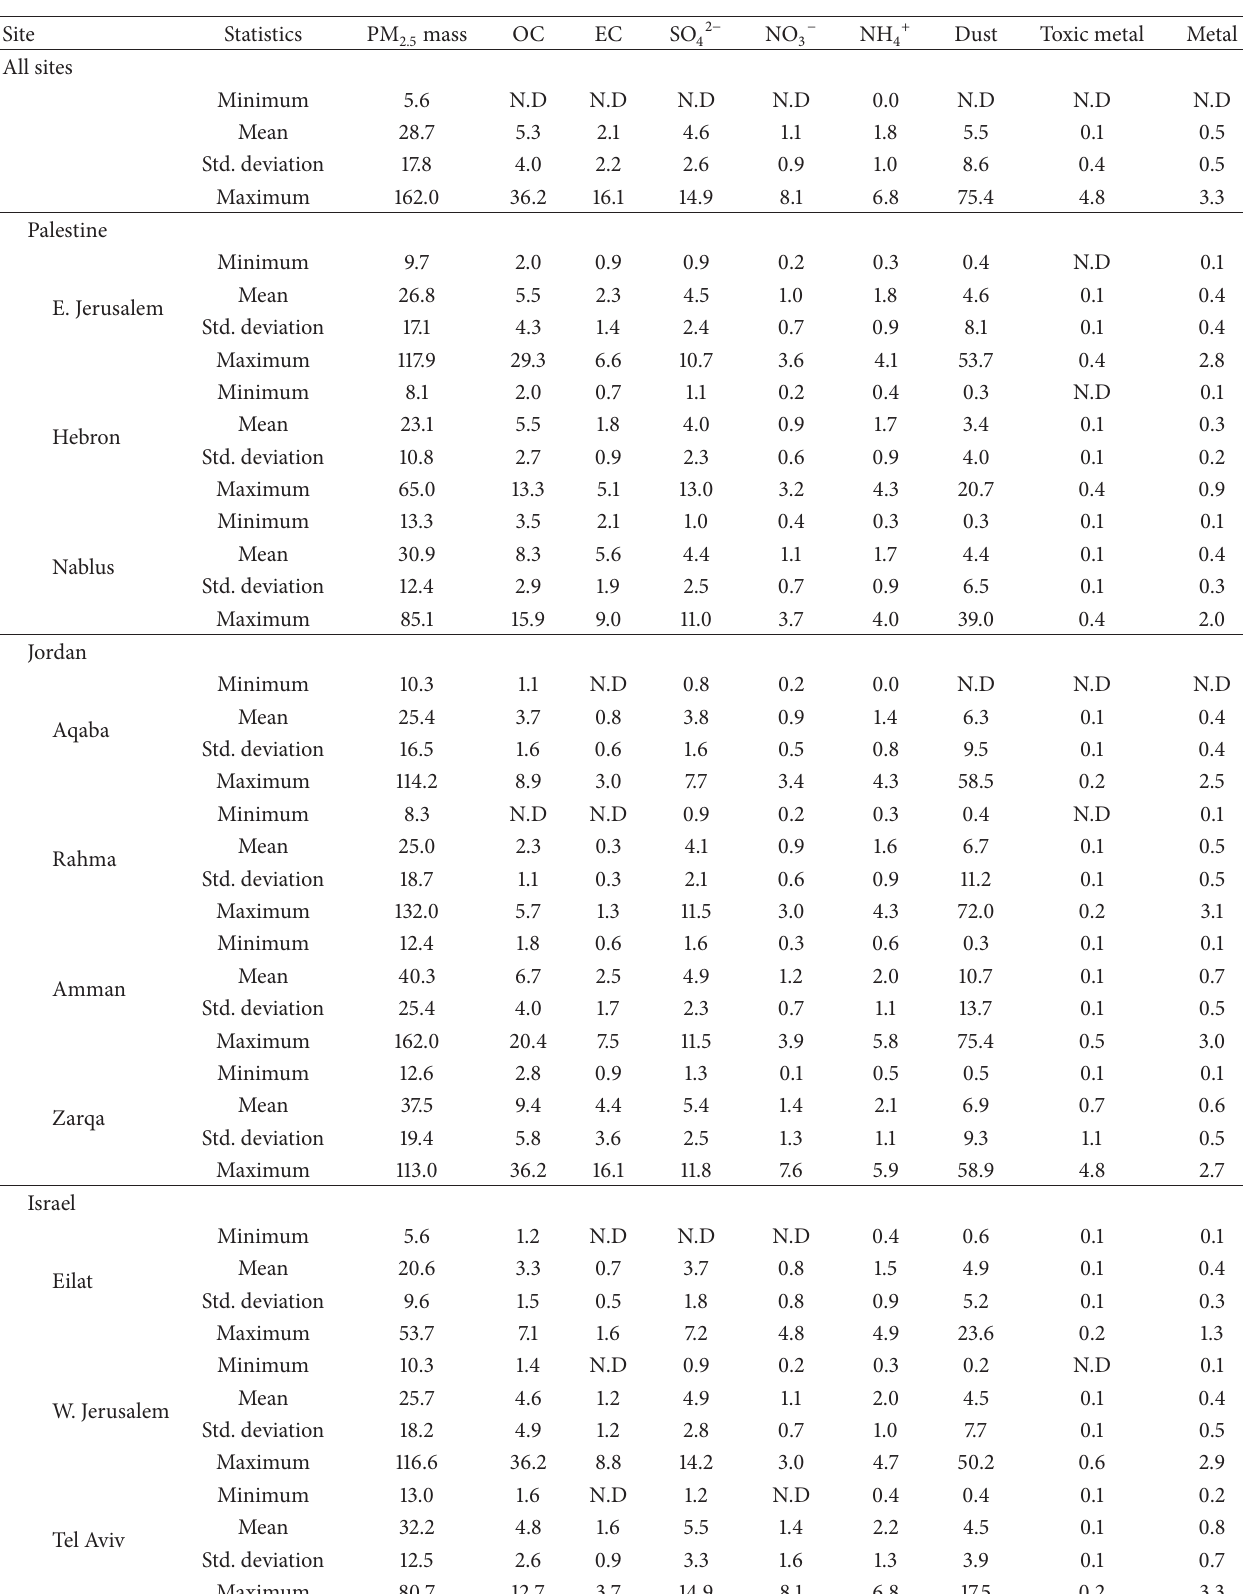
components across the eleven sampling sites, MECARS-2007 (unit: microgram per cubic